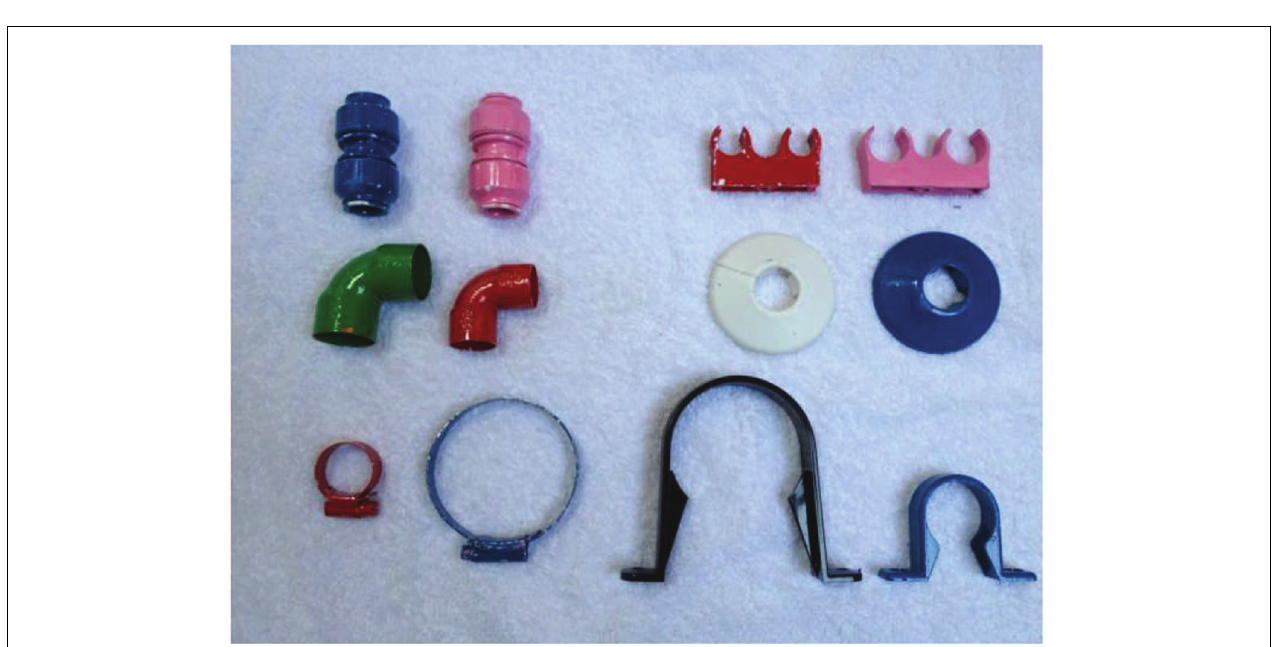
FIGURE 1 | Exposure Array and Comprehension Test Array. From top, left to right: pink teddy, red sock, blue pen, green duck, white connector, blue double pipe clip, copper elbow, chrome pipe collar, green hose clip and pink pipe clip.